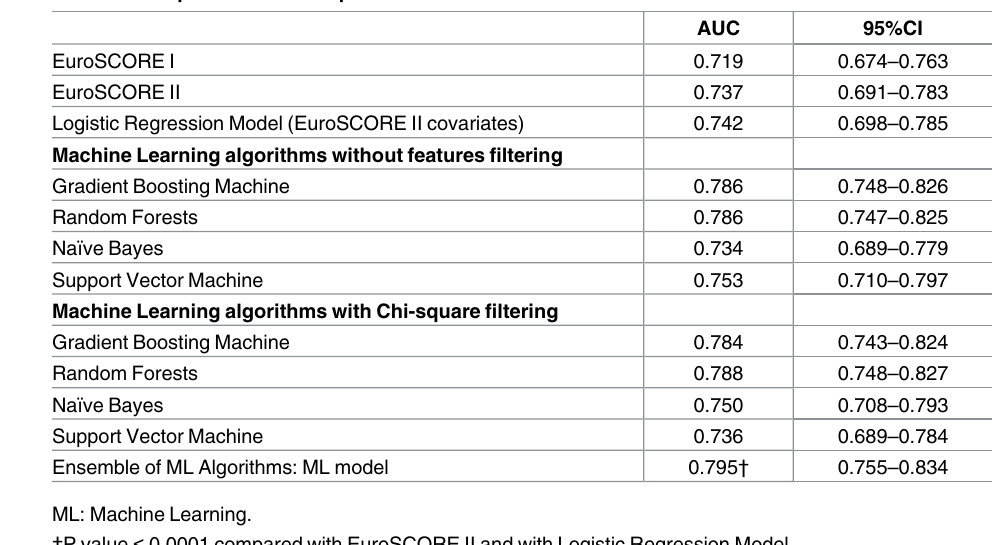
Table 2. Comparison of model performances on the validation